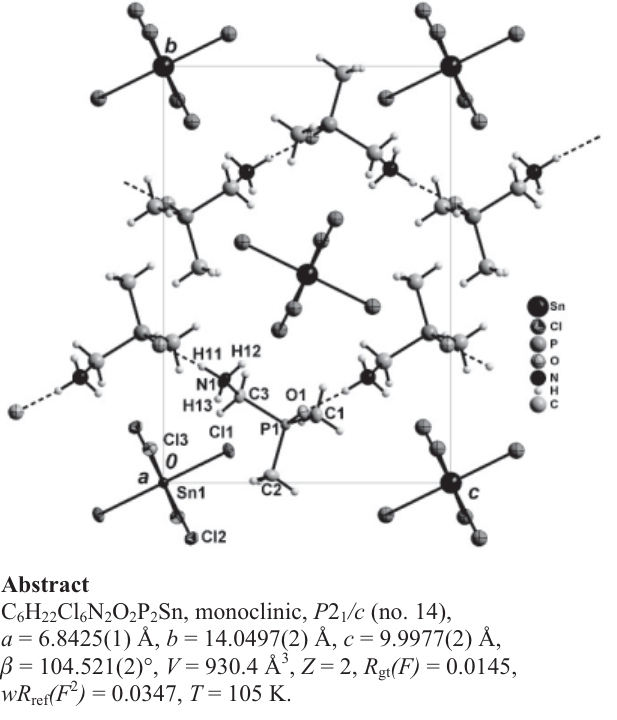
Table 1. Data collection and